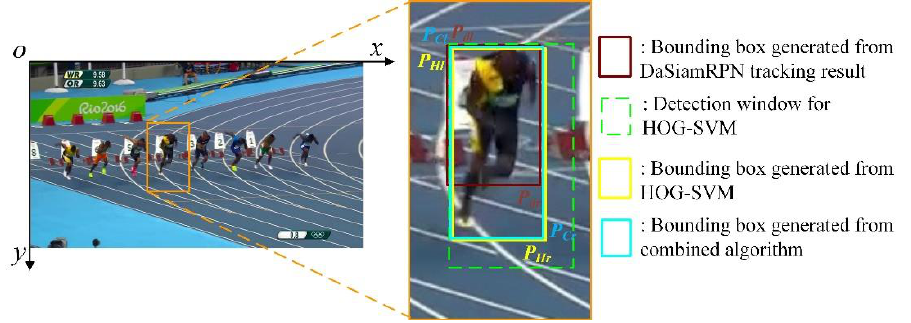
Figure 6. Combined tracking bounding box fusing the results of DaSiamRPN and HOG-SVM.